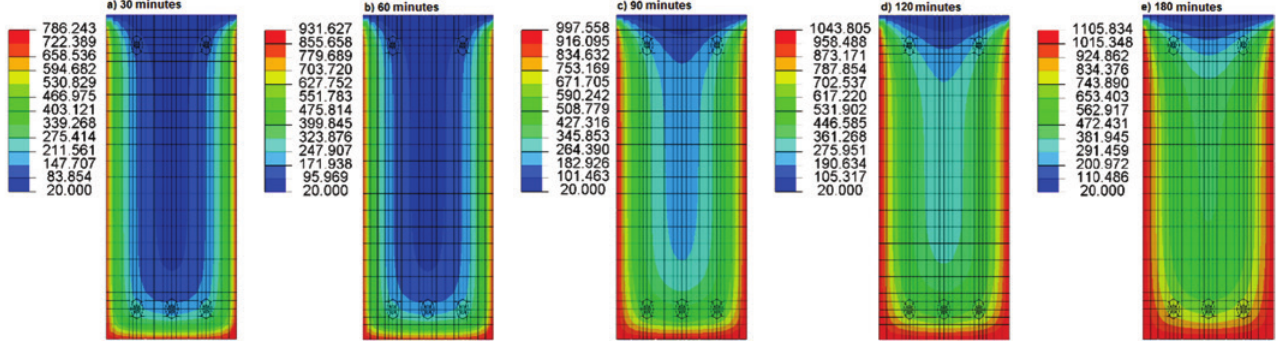
Figure 5 Isotherm B1-III for ratings of (a) 30, (b) 60, (c) 90, (d) 120, and (e) 180